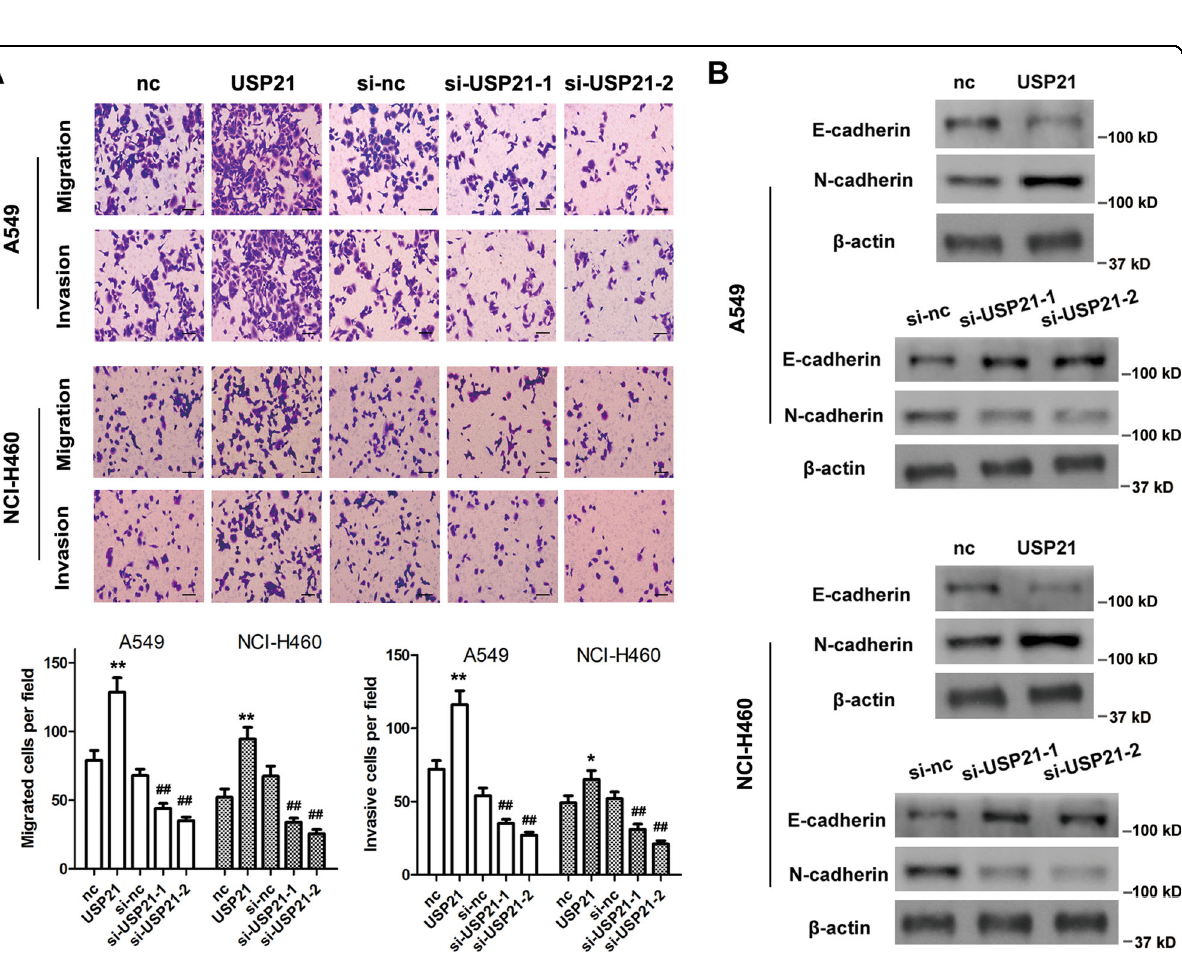
Fig. 3 USP21 promotes NSCLC cell migration and invasion. a Migration and invasion of A549 and NCI-H460 cells after overexpression or silencing of USP21. Representative images (upper panel) and quanti fi cations (lower panel) are shown. Scale bar = 100 μ m. Error bars: mean ± SD. n = 3. * p < 0.05, ** p < 0.01 vs. the normal control (nc) group. ## p < 0.01 vs. si-nc. b E-cadherin and N-cadherin western blot analyses after overexpression or silencing of USP21. β -Actin was used as an internal